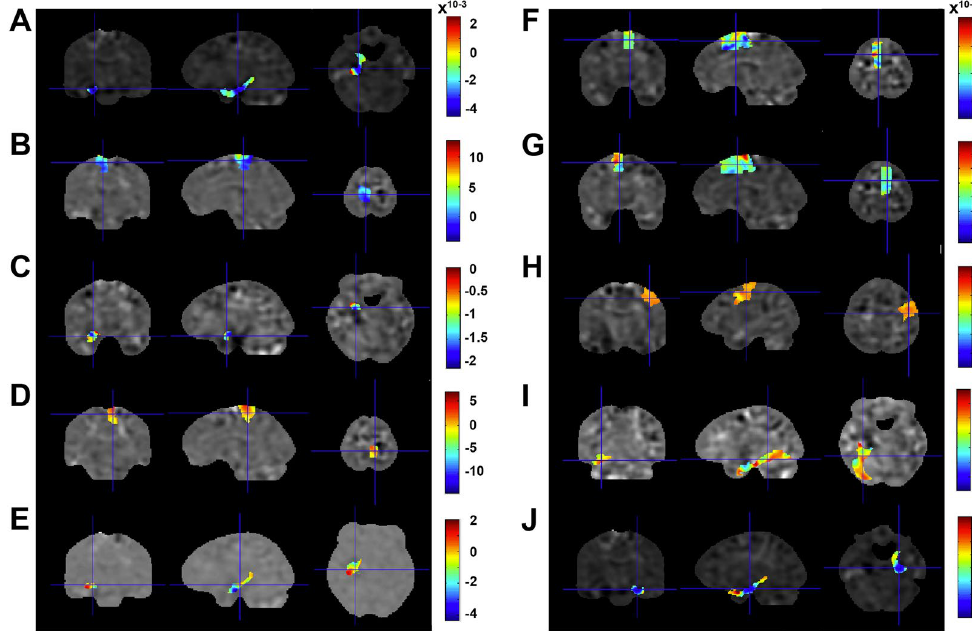
Figure 1. Model weights (colour bar) obtained with the support vector machine algorithm displayed for the brain regions with the highest weights for group classification based on FA (averaged across all cross-validation folds): Left parahippocampal gyrus (A), left paracentral lobe (B), left amygdala (C), right paracentral lobe (D), left hippocampus (E), left (F) and right (G) supplementary motor areal, right precentral gyrus (H), left fusiform gyrus (I), and right parahippocampal gyrus